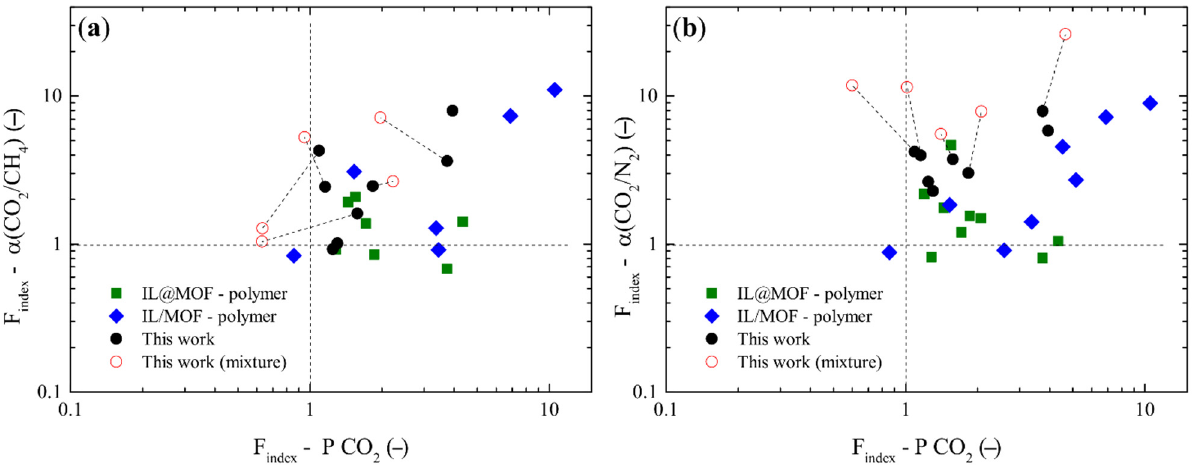
Figure 9. Enhancement CO 2 permeability and selectivity of prepared membranes and reported data from Appendix C for ( a )CO 2 /CH 4 and ( b ) CO 2 /N 2